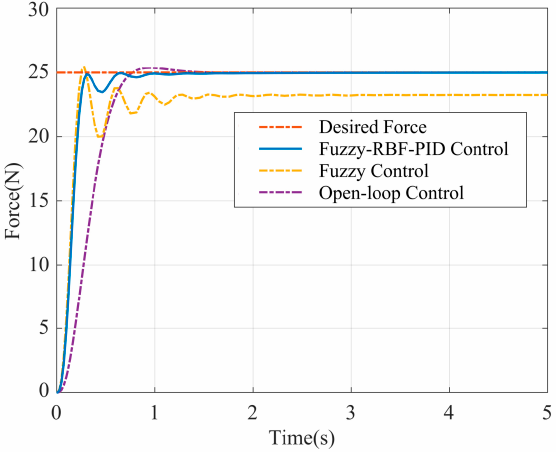
Figure 6. Step response curve of Fuzzy-RBF-PID control.